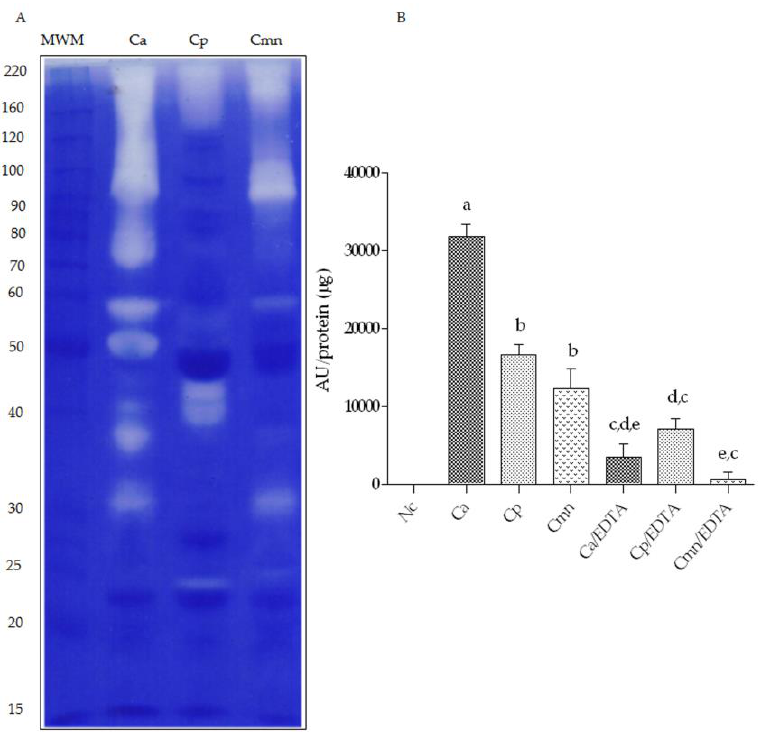
Figure 4. Gelatin zymography in 10% polyacrylamide gels and proteolytic activity using casein substrate. ( A ) Ten micrograms of venom protein from C. aquilus (Ca), Crotalus polystictus (Cp) and C. molossus nigrescens (Cmn) were incubated after electrophoresis for 2.5 h at 37 °C. MWM — molecular weight markers (kDa). ( B ) Proteolytic activity of 100 μg of venom samples in the presence/absence of 50 mM EDTA incubated with casein as a substrate for 2.5 h at 37 °C. Negative control (Nc). Small letters (a,b,c,d,e) show statistical difference (Tukey p < 0.05). Variability in proteases bands is marked with red boxes. Small letters show significant differences (Tukey p < 0.05) between samples, either with or without ethylendiaminetetraacetic acid (EDTA).